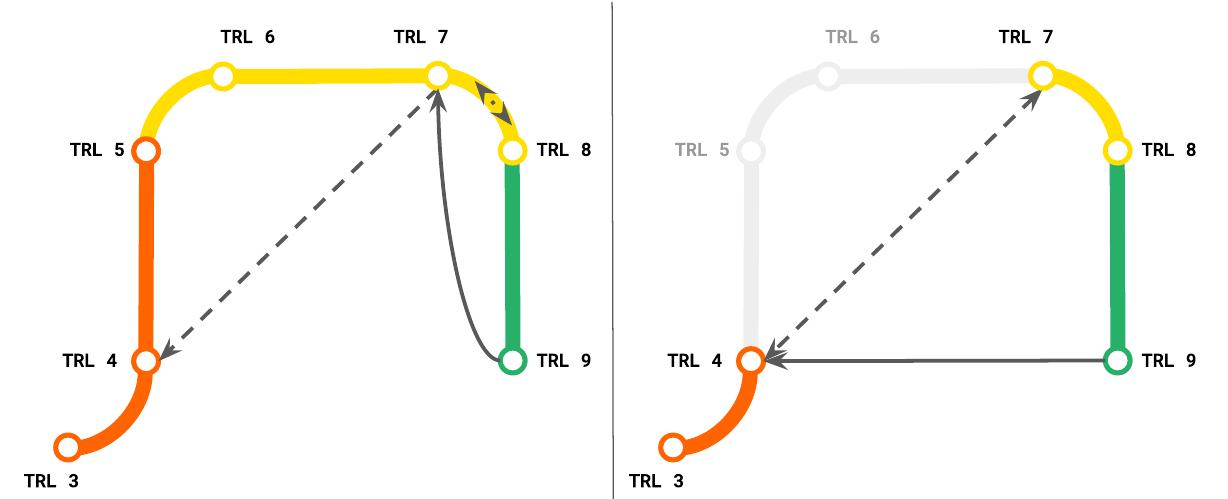
Fig. 4 | Most ML/AI projects live at levels 3 – 9 of MLTRL, not concerned with fundamental R&D — that is, completely using existing methods and imple- mentations, and even pretrained models. In the left diagram (a subset of the Fig.1pipeline,samecolors),thearrowsshowacommondevelopmentpatternwith MLTRL in the industry): projects go back to the ML toolbox to develop new fea- tures (dashed line), and frequent, incremental improvements are often a practice of jumping back a couple of levels to Level 7 (which is the main systems integra- tionsstage).AtLevels7and8westresstheneedforteststhatrunuse-case-speci fi c critical scenarios and data-slices, which are highlighted by a proper risk- quanti fi cation matrix 78 .Reviews at theseLevels commonly catch gapsor oversight in the test and validation scenarios, resulting in frequent cycles back to Level 7